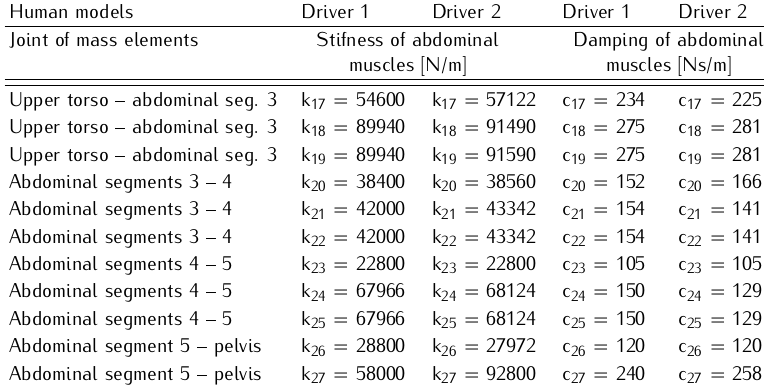
Controlling the magnetorheological suspension...